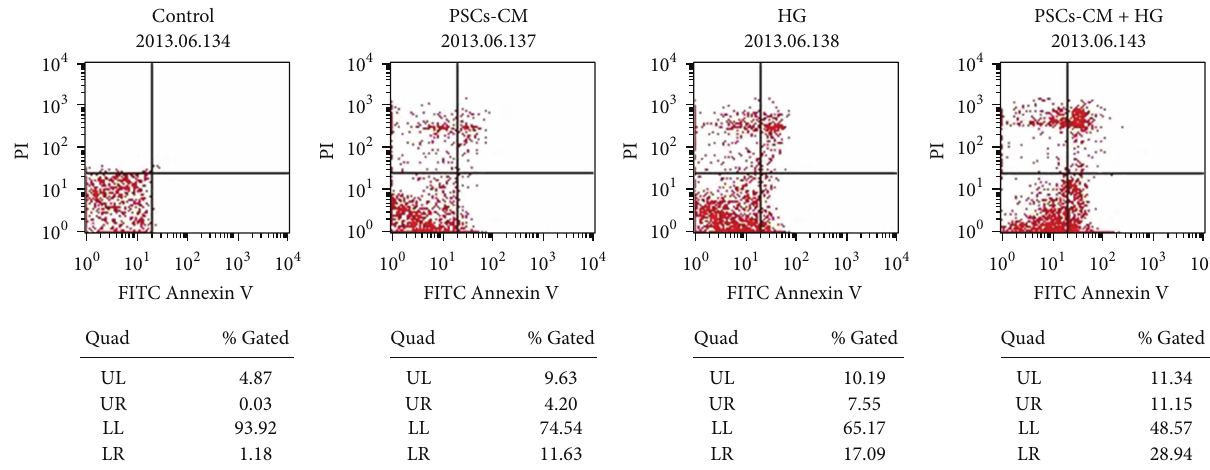
Figure 5: PSCs-CM increases INS-1 cell apoptosis in vitro. The apoptosis of INS-1 cells was detected by Annexin V-FITC/PI apoptosis detection kit. Both PSCs-CM and HG alone caused marked and significant increases in INS-1 cell apoptosis, and the effects of both treatments on apoptosis were additive, with the combination of PSCs-CM and HG exerting a significantly more detrimental effect than either treatment alone.